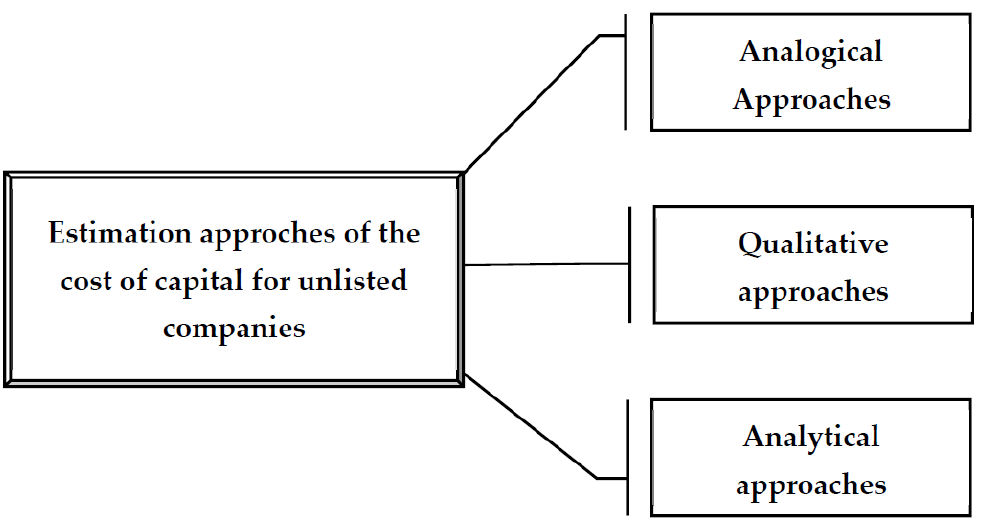
Figure 1. Estimating approaches of the cost of capital for unlisted companies.